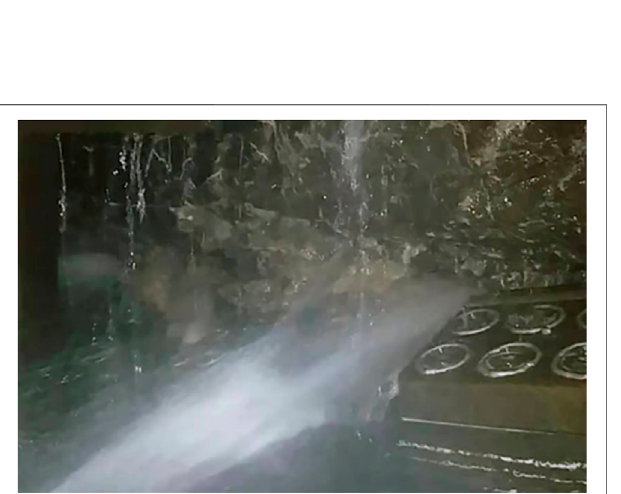
FIGURE 3 | A real image of detected karst cave in limestone formation near the tunnel.